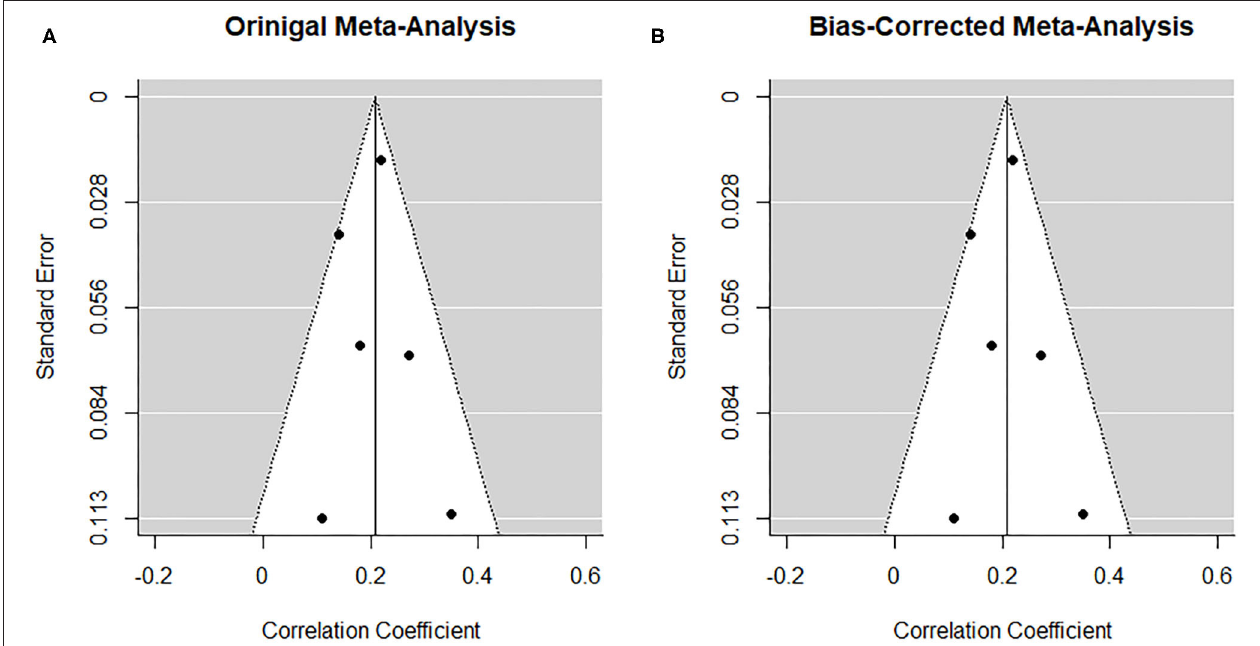
FIGURE 9 | Funnel plots before (A) and after (B) applying the trim-and-fill method corresponding to the prospective association between maternal depression at one timepoint and paternal depression at a later timepoint during the perinatal